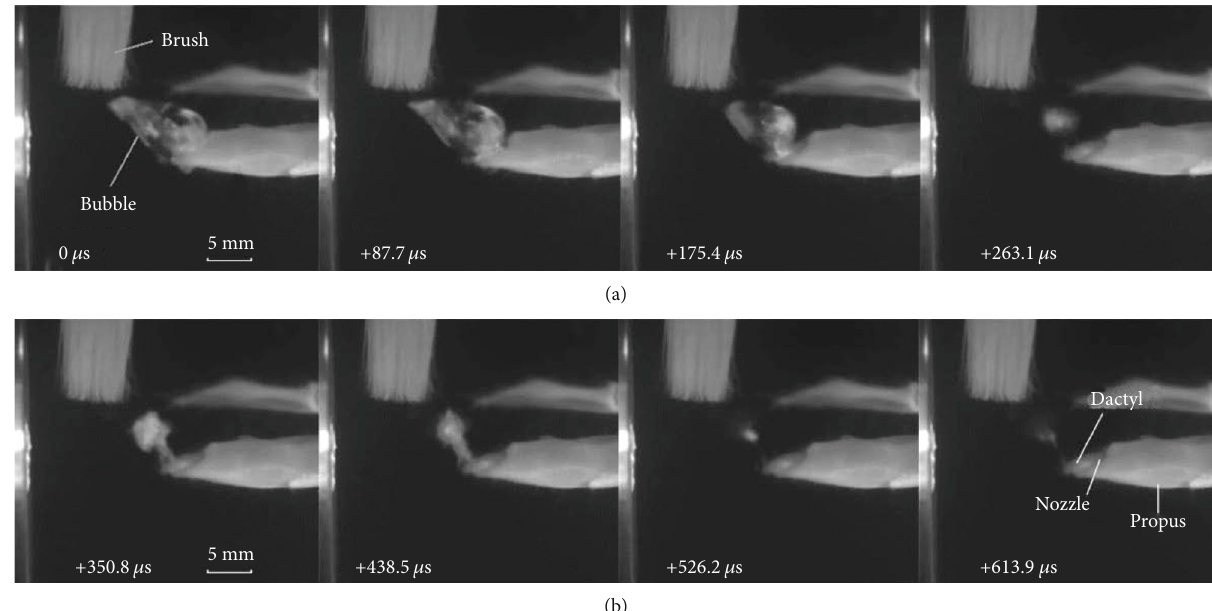
Figure 5: High-speed images from the top of the claw. (a) The pictures of the compression of cavitation bubbles. The volume of the conical bubble reduces to is the minimum. (b) The pictures of the rebound of cavitation bubbles. The bubbles rebound many times without a speci fi c shape and eventually